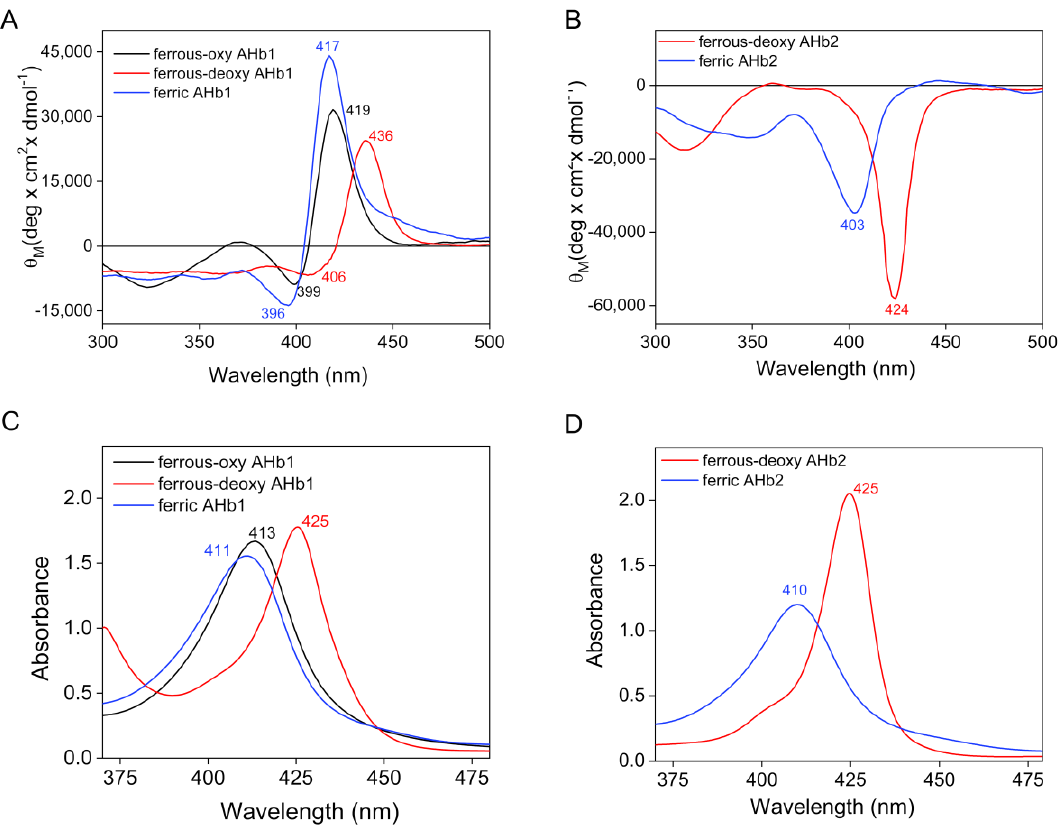
Figure 5. Circular dichroism ( A , B ) and absorption ( C , D ) spectra of AHb1 and AHb2 in the Soret region. CD spectra ( A , B ) were recorded using 33 µM heme proteins in 10 mM Tris-HCl buffer, pH 8.0, and absorption spectra ( C , D ) using 20 µM heme proteins in 20 mM Tris-HCl buffer, pH 8.0.